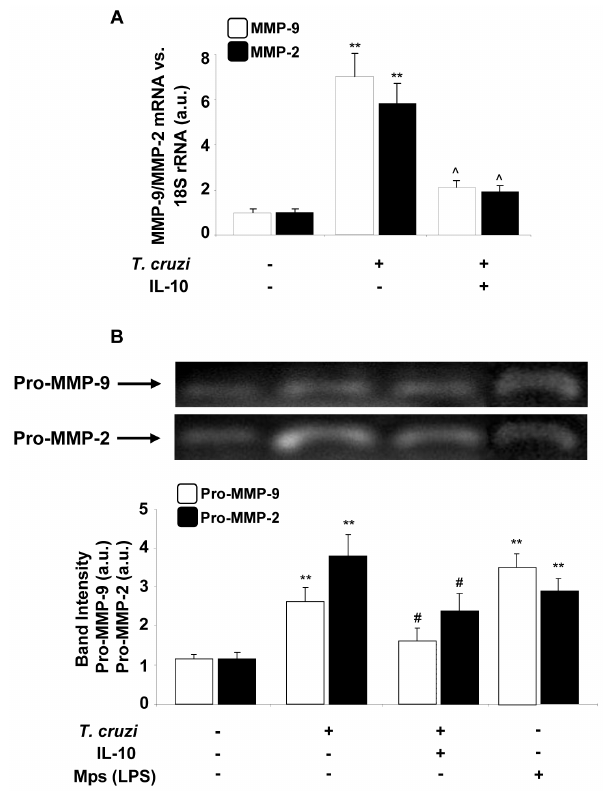
Figure 5. Effect of IL-10 treatment on cardiac matrix metallo- proteinase (MMP)-9 and MMP-2 expression and activity after T. cruzi infection. (A) Neonatal cardiomyocytes were treated with IL-10 (20 ng/ml) for 15 min followed by 48 h of T. cruzi infection. MMP-9 and MMP-2 mRNA levels were analysed by Q-RT-PCR. (B) Under the same conditions as in A, zymograms of MMP-9 and MMP-2 activity were carried out in culture media of neonatal cardiomyocytes after 72 h of T. cruzi infection. White bars indicate the values of MMP-9 activity and black bars indicate the values of MMP-2 activity. Peritoneal macro- phages (Mps) were stimulated with LPS for 24 hours and used as a positive control for MMP. In A, the results were normalized against 18S and represent the mean 6 SD of three independent experiments. For B, results represent the relative densitometric analysis of the activities of Pro-MMP-9 and Pro-MMP-2 of four experiments performed. **p , 0.01 vs. Control cells;ˆp , 0.01, # p , 0.05 vs. T. cruzi infected cells.